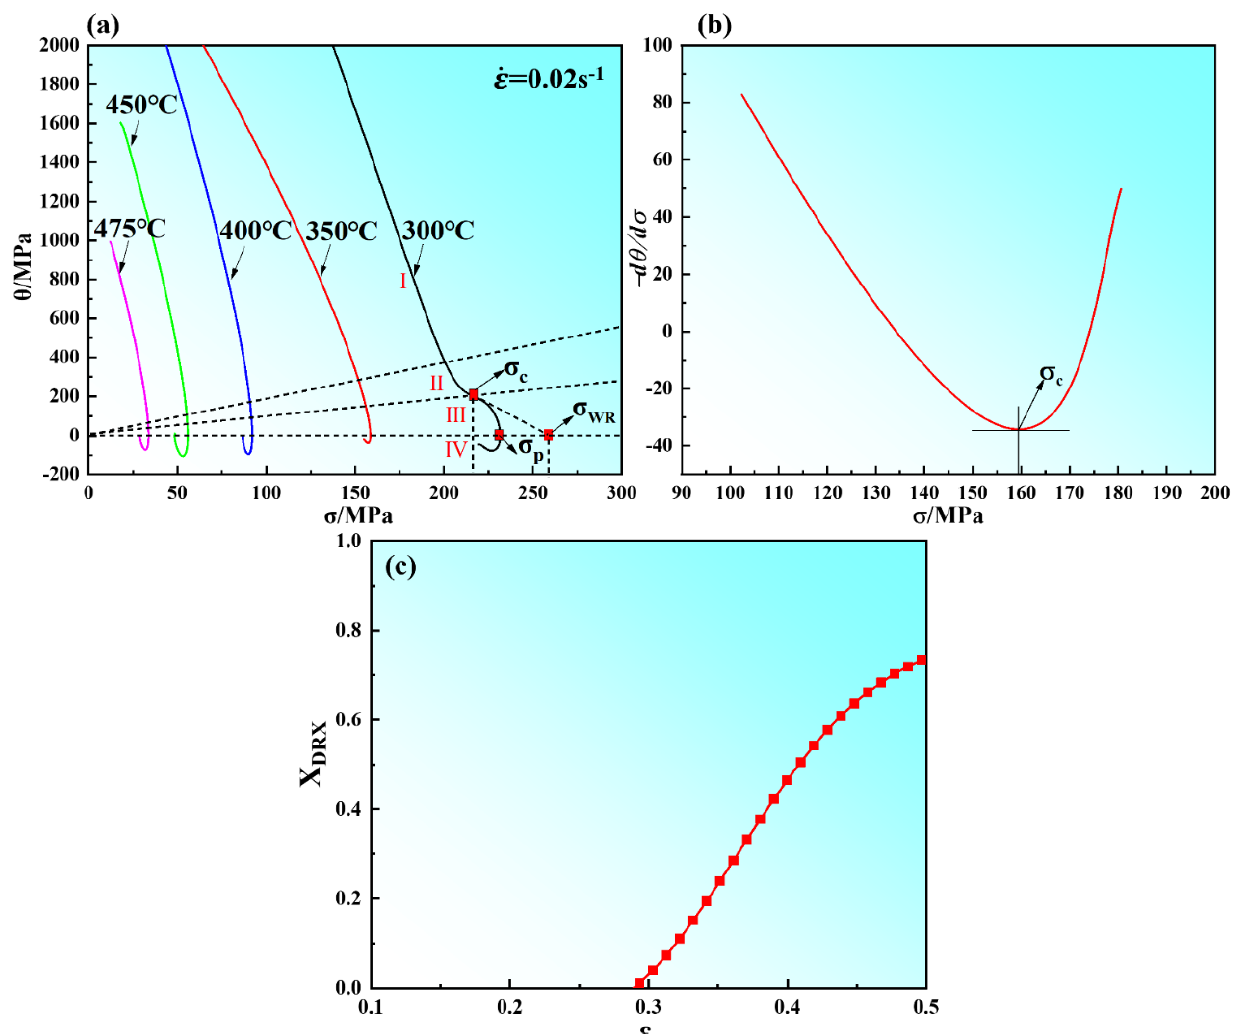
Figure 4. Relationship between θ and σ : ( a ) θ - σ , ( b ) -( d θ / d σ )- σ . ( c ) Relationship between X DRX and ε .